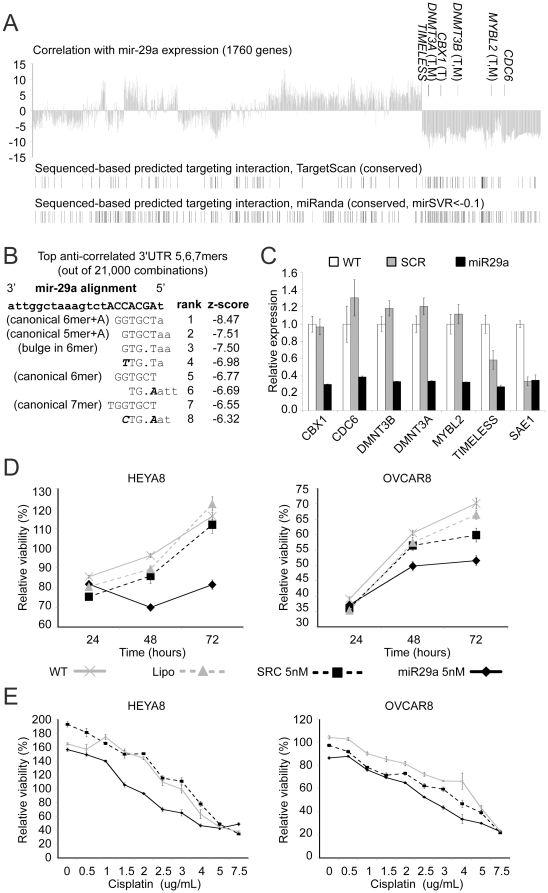
MiR-29a impacts anti-correlated gene targets and ovarian cancer cell viability.(A) Correlation of gene expression with miR-29a expression (genes from Figure 4B, same ordering). Predicted miR-29a targets are indicated. (B) Top eight words (of all 5, 6 and 7mers) enriched in 3′-UTRs of mRNAs anti-correlated with miR-29a expression (FDR<1e-6). (C) QPCR analysis showing relative quantity of selected miR-29a anti-correlated gene targets after miR-29a overexpression in HEYA8 ovarian cancer cells (SCR, scrambled control; WT, untreated; two-sided t-test P<0.05, mir-29a vs SCR and miR-29a vs WT, each comparison, except for SAE1). (D) MTS assays demonstrating the effect of miR-29a overexpression on proliferation of HEYA8 and OVCAR-8 cells (Lipo, lipofectamine-treated alone, no miRNA; two-sided t-test P<0.001, miR-29a vs each of three control groups at both 48 h and 72 h). (E) Effect of miR-29a (72 h) on proliferation, under a range of concentrations of cisplatin treatment (at 48 h). Error bars represent standard error.